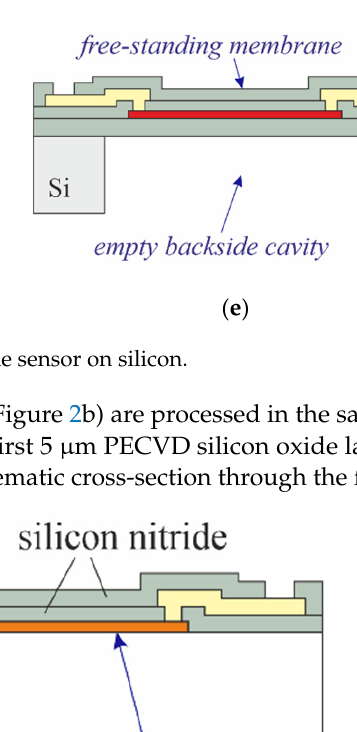
Figure 3. Fabrication of the sensor on silicon.